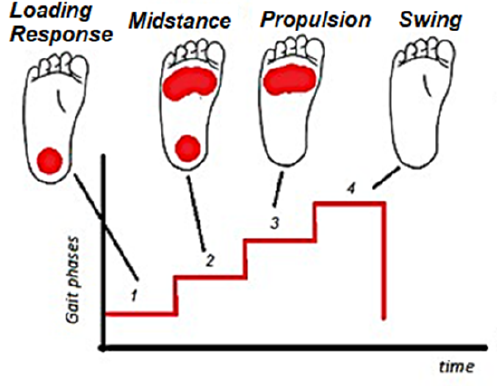
Figure 3. Walking phase identification based on activation sensor sequence. “Loading response” is based on calcaneus activation, “midstance” is based on calcaneus, lateral forefoot (5th metatarsal head), central forefoot (between the 2nd and 3rd metatarsals heads), and calcaneus activation, “Propulsion” is based on lateral forefoot (5th metatarsal head) and central forefoot (between the 2nd and 3rd metatarsals heads) activation, and “Swing” is based on no activation.